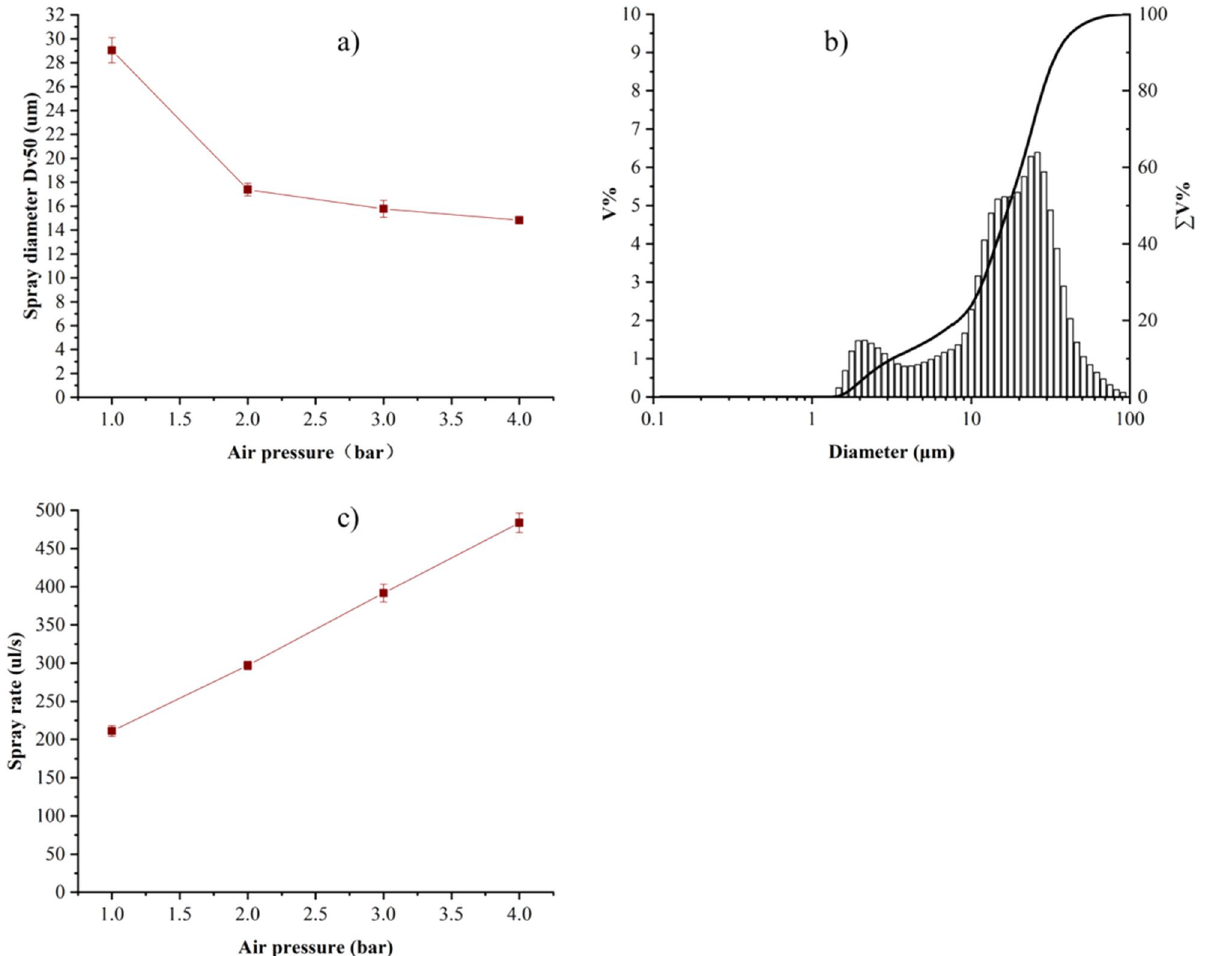
Figure 5. ( a ) Variation of spray particle diameter Dv50 at different air source pressure; ( b ) the spray particle diameter distribution at 2 bar air source pressure; ( c ) variation of spray rate at different air source